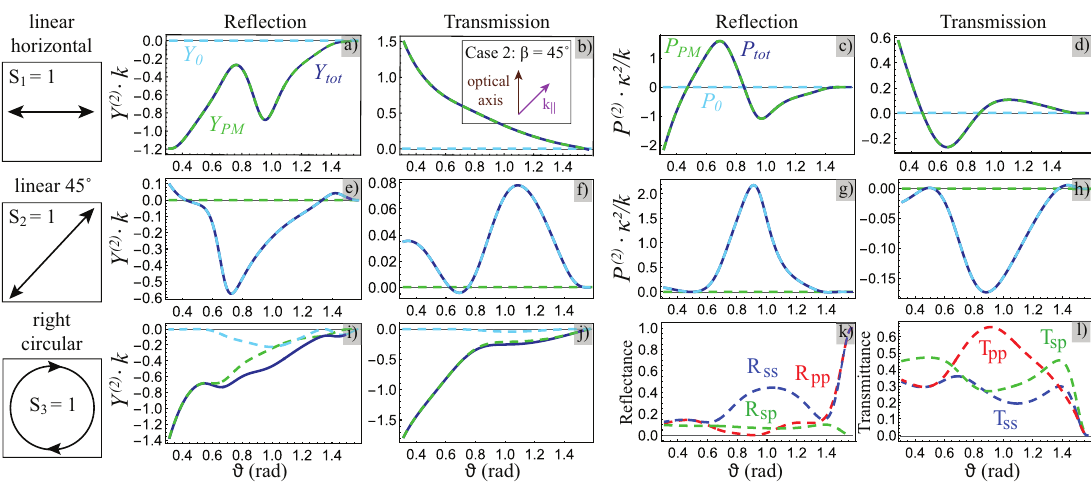
| 2 ) and (l) transmittances ( T = | f t | 2 ) for ij ij ij